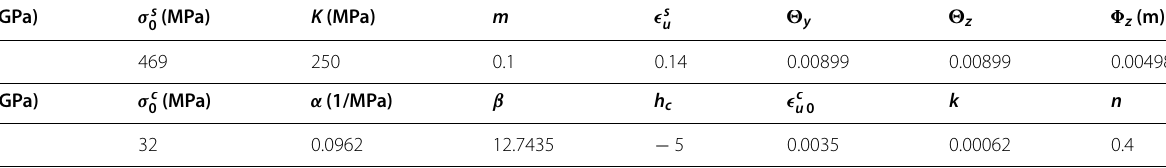
Table 1 Model parameters used in the column compression and beam bending simulations when ǫ c u depends on the hydrostatic stress.